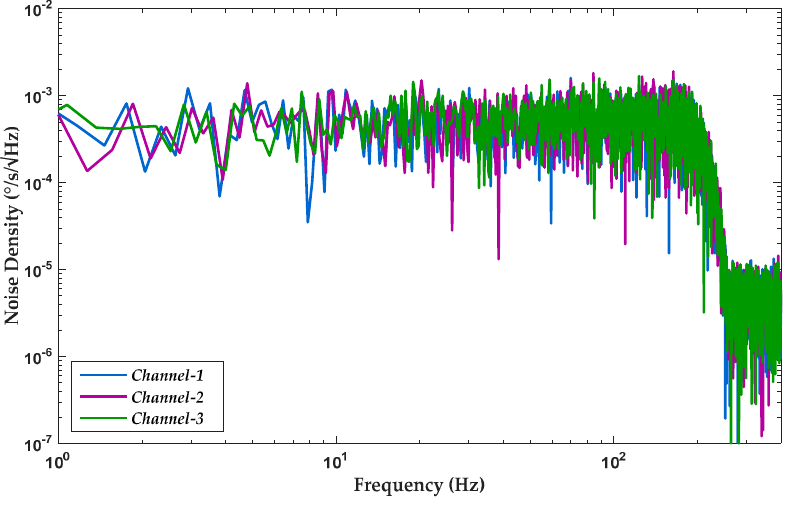
Figure 20. Measured noise floor of the proposed gyroscope ASIC.